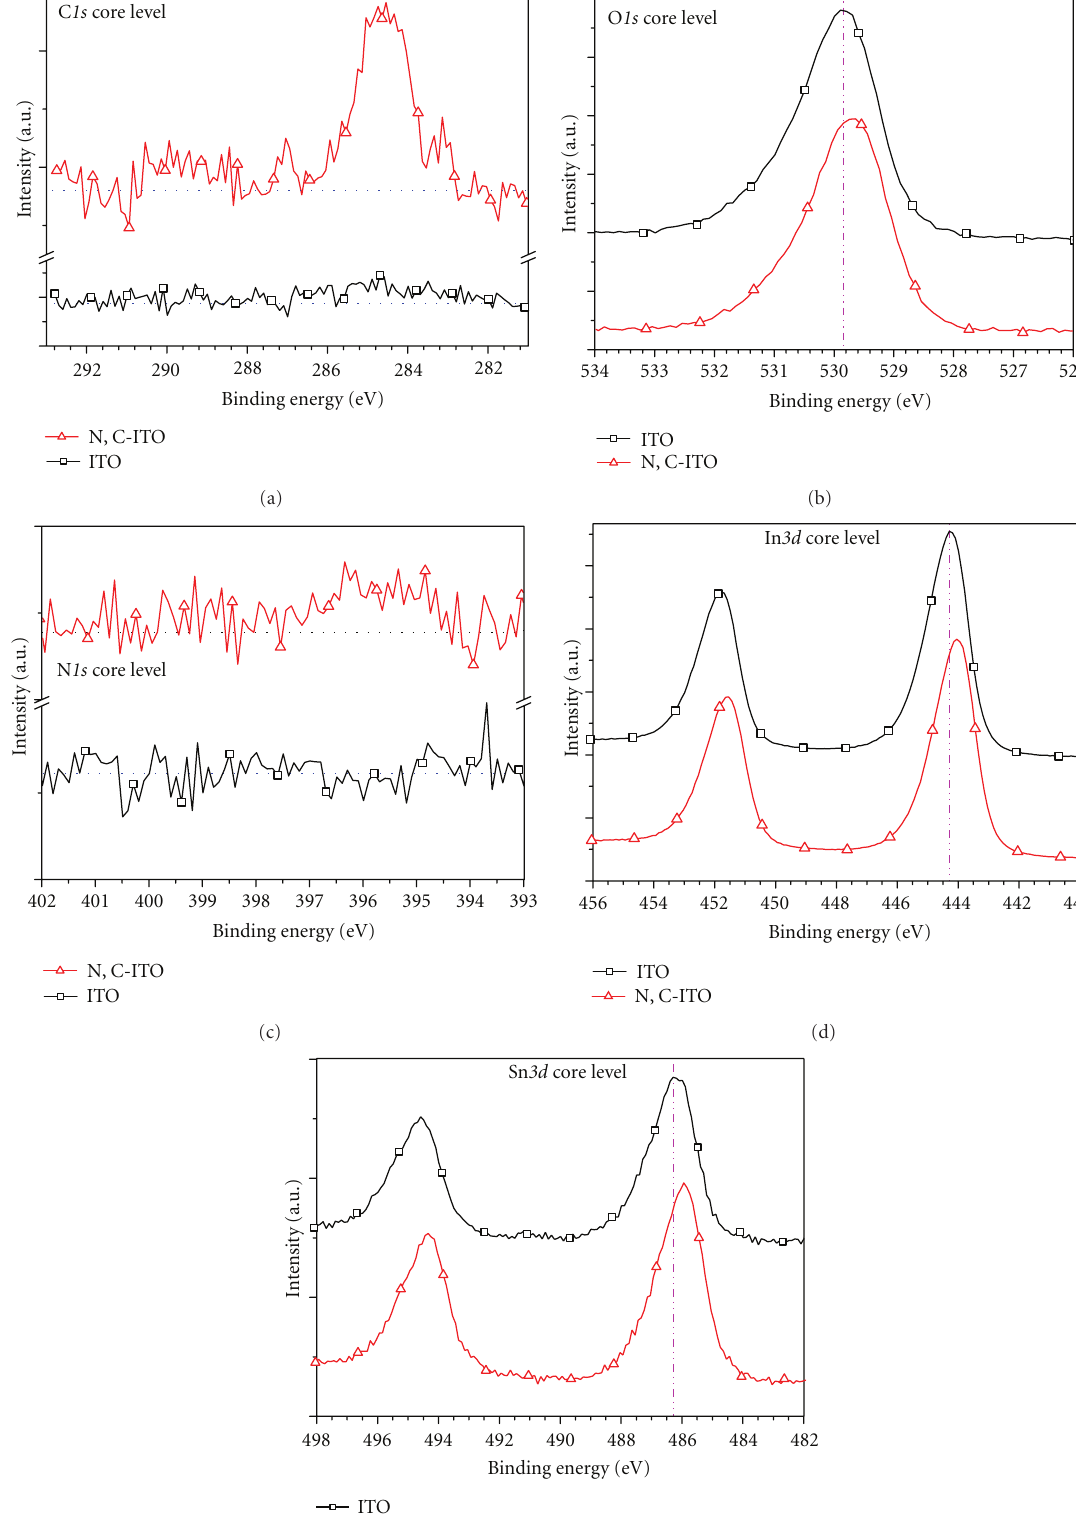
Figure 5: XPS high-resolution spectra of: (a) C 1s , (b) O 1s , (c) N 1s , (d) In 3d , and (e) Sn 3d core levels for the N,C-ITO and ITO film